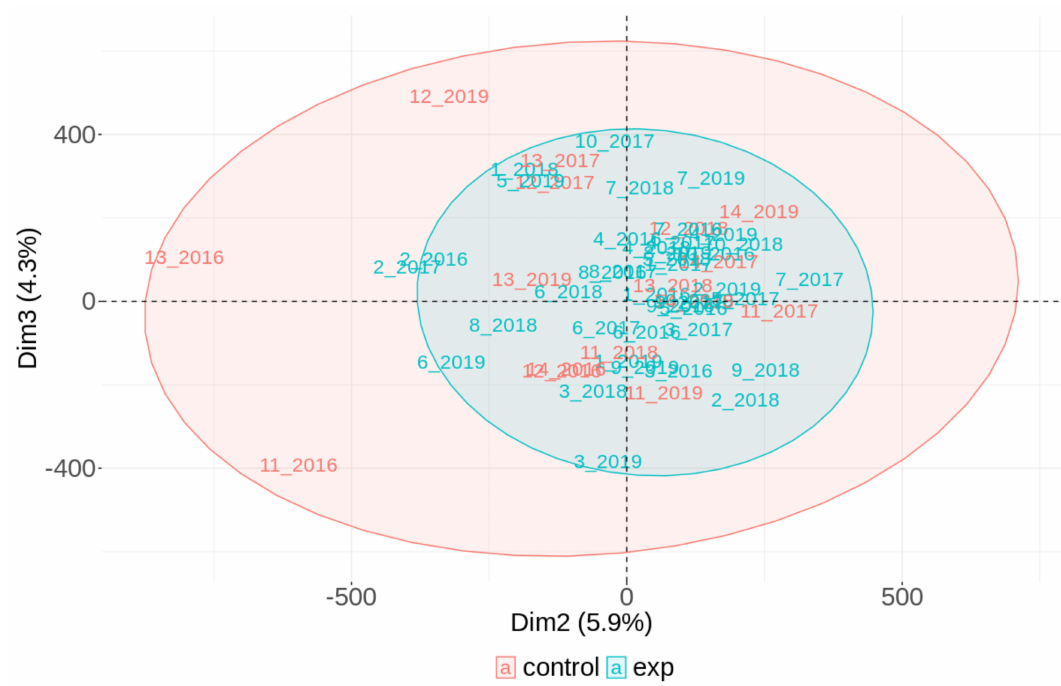
Figure 1. A comparison of the DNA methylation pattern analyzed by PCA in groups of NP-exposed and control subjects pooled from four consecutive years: results for the whole CpG data set analyzed by array chips.